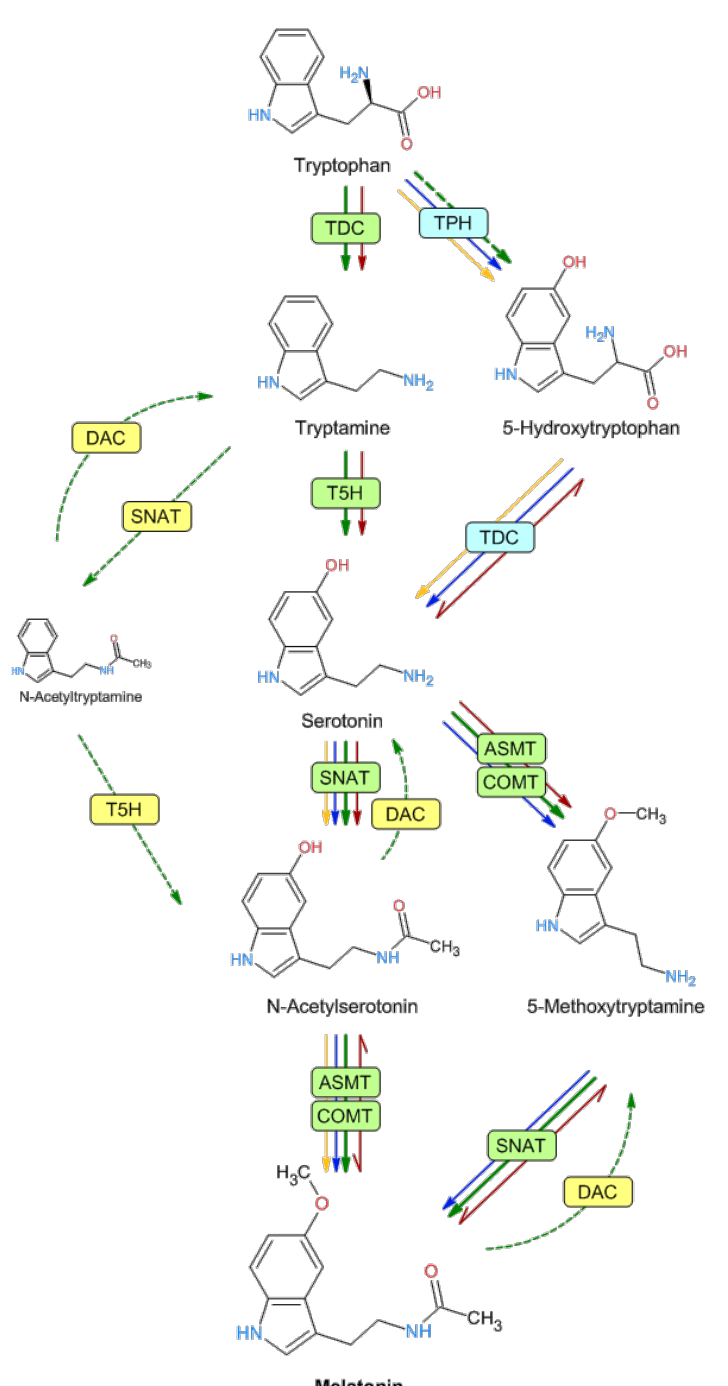
Figure 2. Biosynthetic melatonin pathways in mammals, plants, and microorganisms. The names of the different enzymes are described in the text. The different arrow colors denote plants (green), animals (blue), bacteria (yellow), and yeasts (red). Dashed lines indicate unproven reactions.